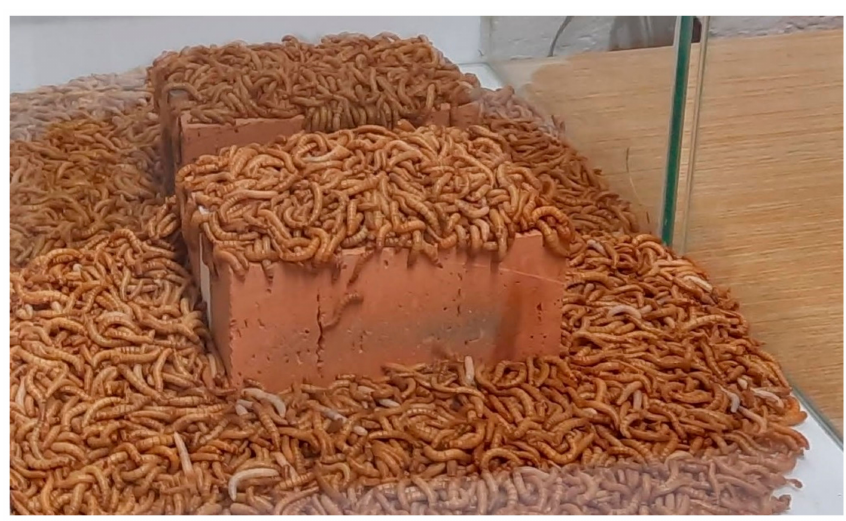
Figure 4. Specimens just after placing Tenebrio molitor in glass